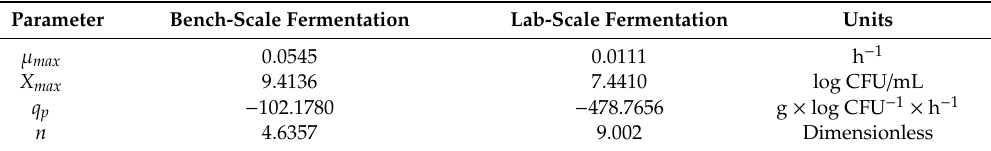
Table 3. Kinetic parameters of the kinetic model of submerged fermentation at the bench scale for L. plantarum ATCC 8014 culture on a plasma-based medium. Source: Own elaboration.